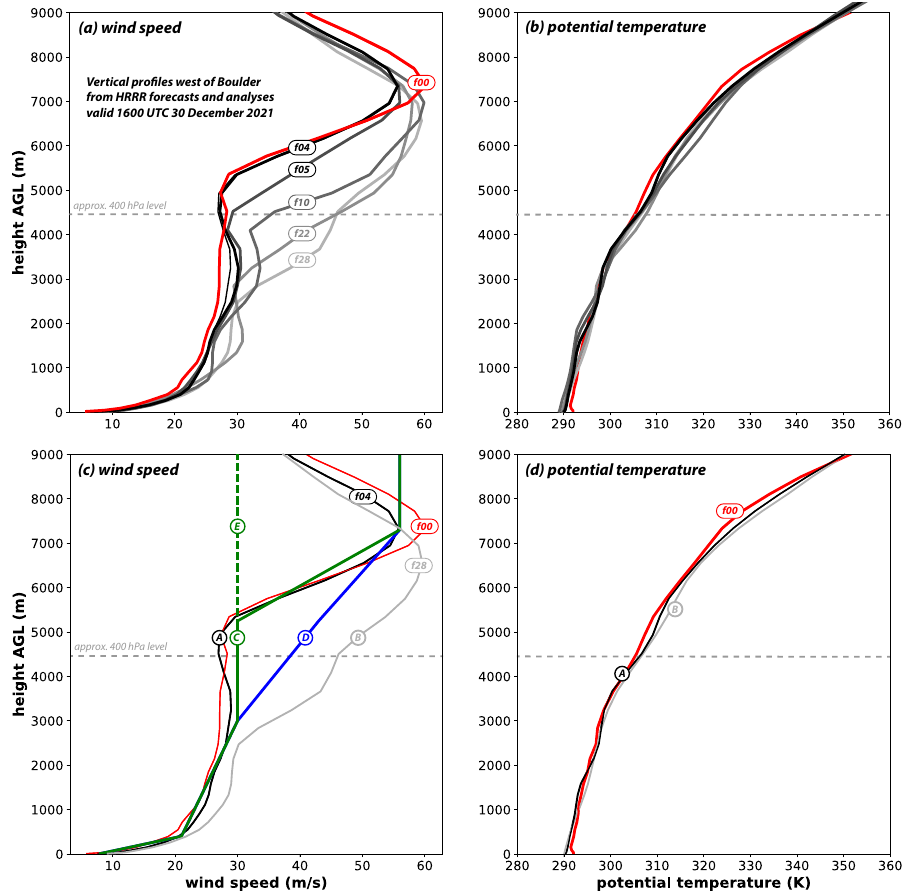
Figure 11. Vertical profiles of ( a , c ) wind speed (m/s) and ( b , d ) potential temperature (K) representing Boulder’s inflow environment valid at 1600 UTC 30 December 2021, extracted from HRRR analysis (f00) and earlier cycles (fNN), where NN is the forecast lead time in hours. In ( c , d ), the f04 and f28 profiles are also labeled A and B, and wind profiles C, D, and E shown in ( c ) are used in experiments described in the text. Experiments using wind profiles C, D, and E employed temperature profile A. The approximate height of the 400 hPa level at the upstream location is indicated (dashed grey horizontal